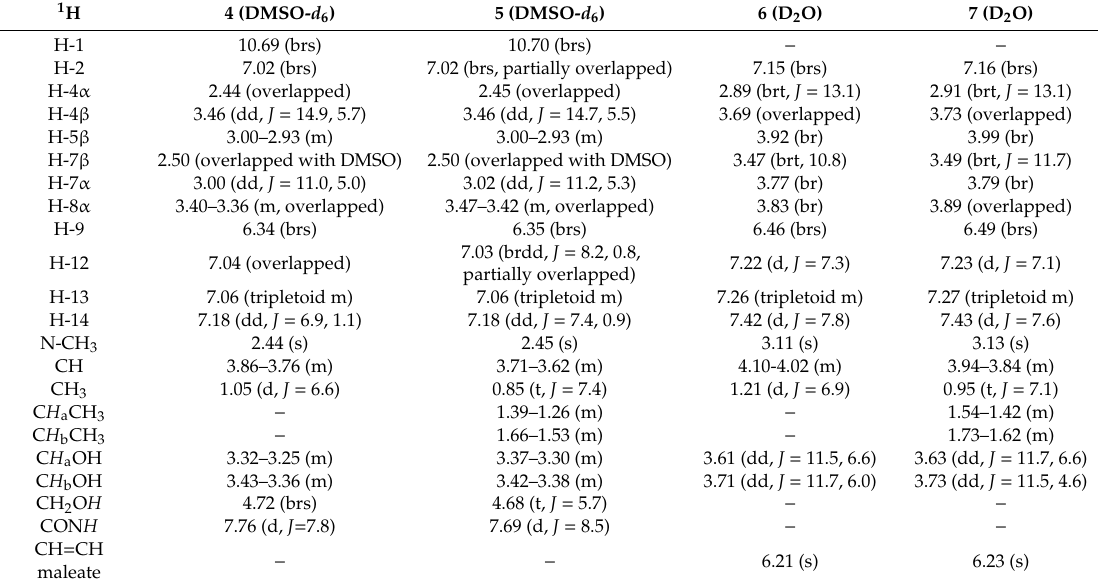
Table 1. 1 H NMR chemical shifts (ppm) a and coupling constants (Hz) b of compounds 4 – 7 .